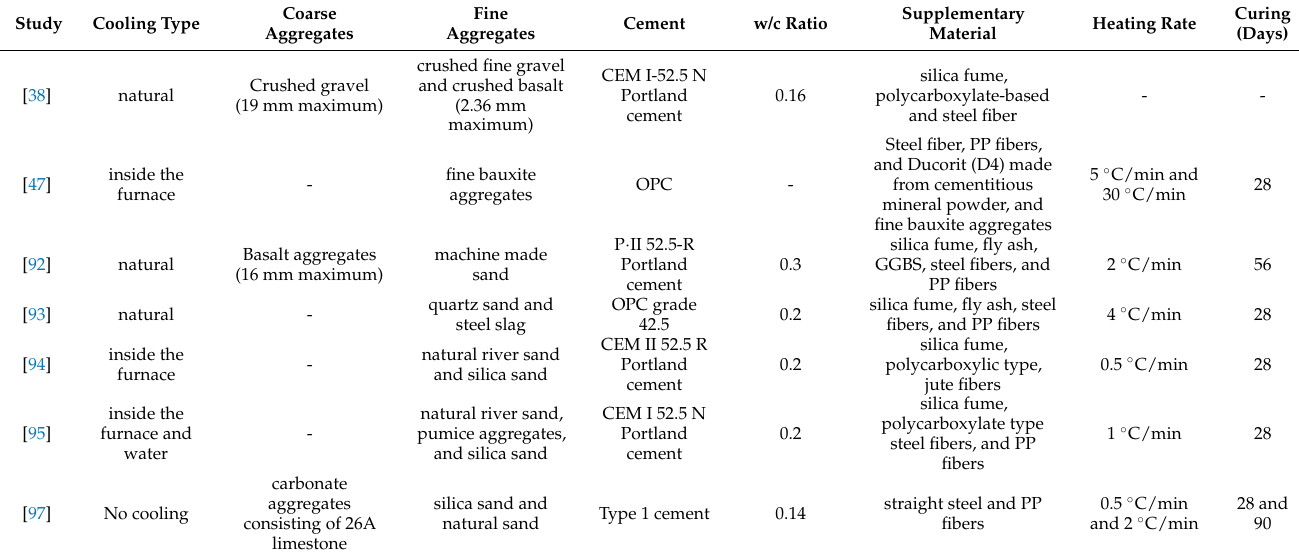
Figure 30. Relative splitting tensile strength of UHPC under different heating rates. S: Steel Fiber, H: Hybrid between steel and Polypropylene Fibers [97].